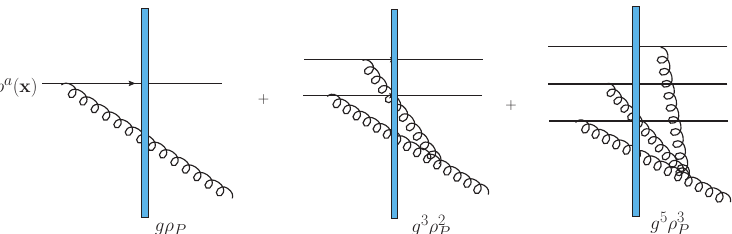
Figure 1: Diagrams illustrating the first saturation correction to single inclusive gluon production. Each horizontal line represents color charge density of proton at differ- ent transverse positions. The solid rectanglular bar indicates the Lorentz contracted nucleus. There are tens of diagrams at order g 3 ρ 2 diagrams are shown